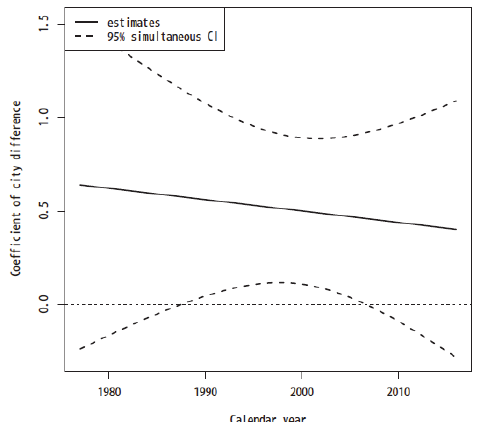
Fig. 5. Estimates and 95% simultaneous CI of regression coefficient in "world"